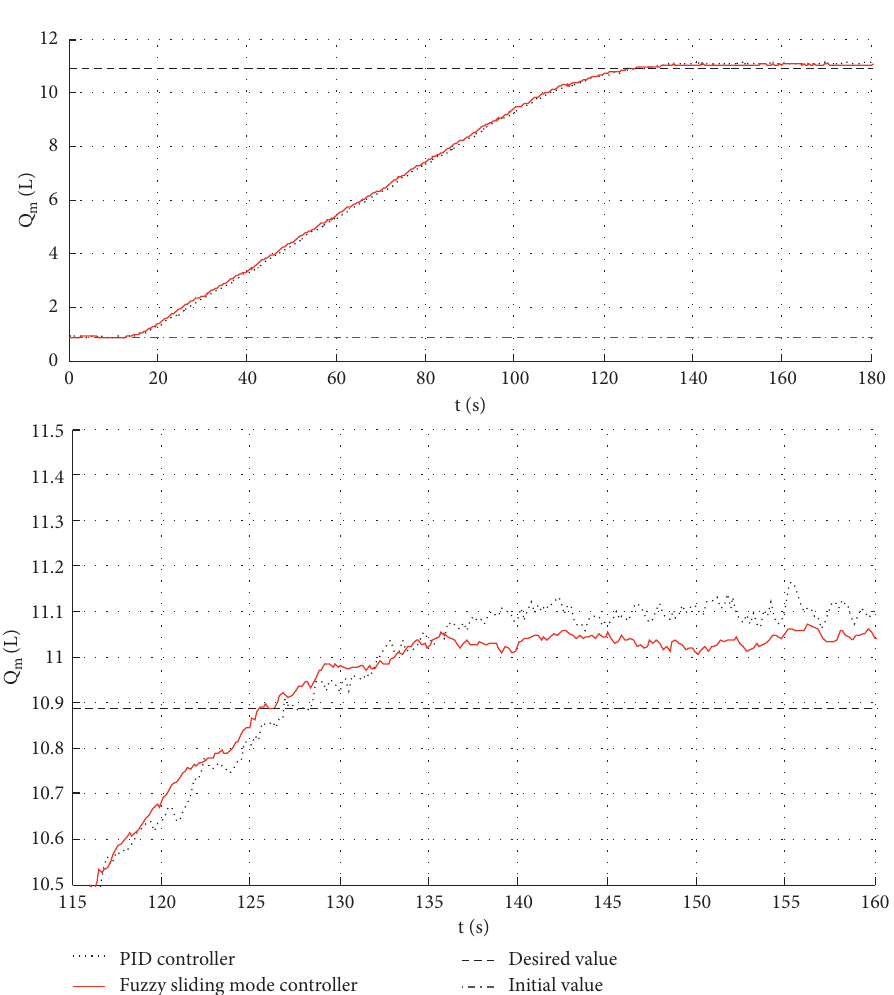
Figure 11: Experimental results of different control methods under no